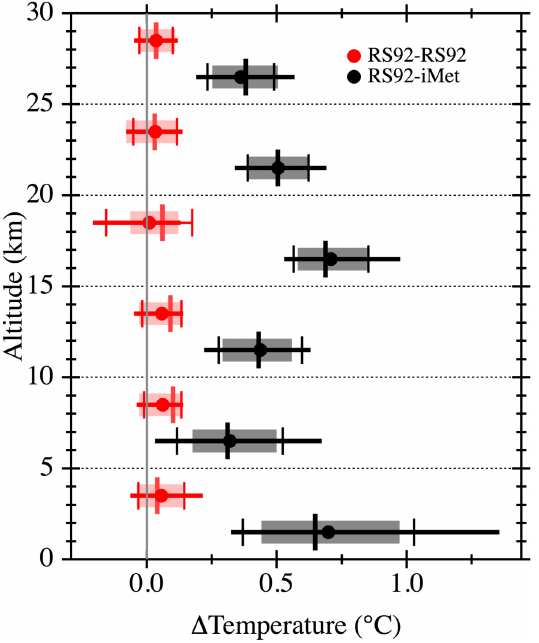
Fig. 6. The 26 RS92-iMet 1P profiles, of which 4 are anomalous. If the anomalous profiles are included (excluded) 30% (23%) of the 1P (open circles) exceed the combined measurement uncertainties (2 σ ) presented in Table 2, and 83% of these excessive 1P are located above